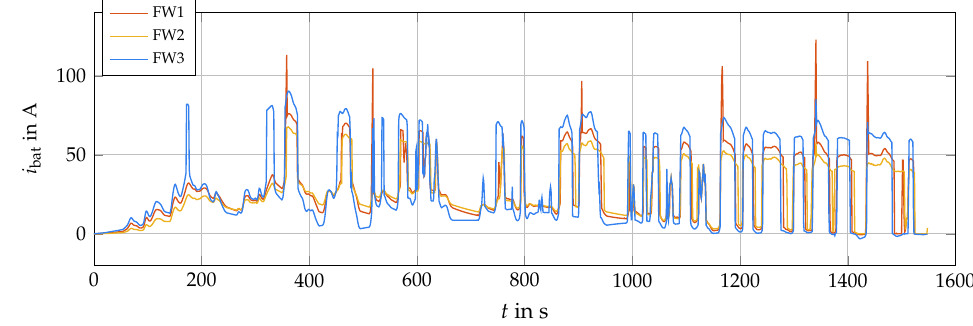
Figure 8. Battery current i bat along the E11 driving cycle for the NMPC. Table 6 reports the overall results for the E11 driving cycle, while Table 7 reports the detailed results along the BR driving cycle. The first column represents the non-hybrid BEB for the respective driving cycle. It can be seen that the NMPC as the control strategy increased the battery lifetime the most, as well as the HESS including FW2 achieved the longest battery lifetime out of the KESS configurations. For some HESS configurations, the maximum battery current for the rule-based control is higher than for the stand-alone battery system. This effect is due to a high-power peak with the KESS being already fully discharged at this point, leading to a higher battery peak current because of the additional bus weight due to the KESS. Additional data about the average (AVG) and standard deviation (SD) of the C-rate of the battery can be found in Appendix A. Table 6. Comparative results of the mobile KESS configurations along the E11 driving cycle. Parameter